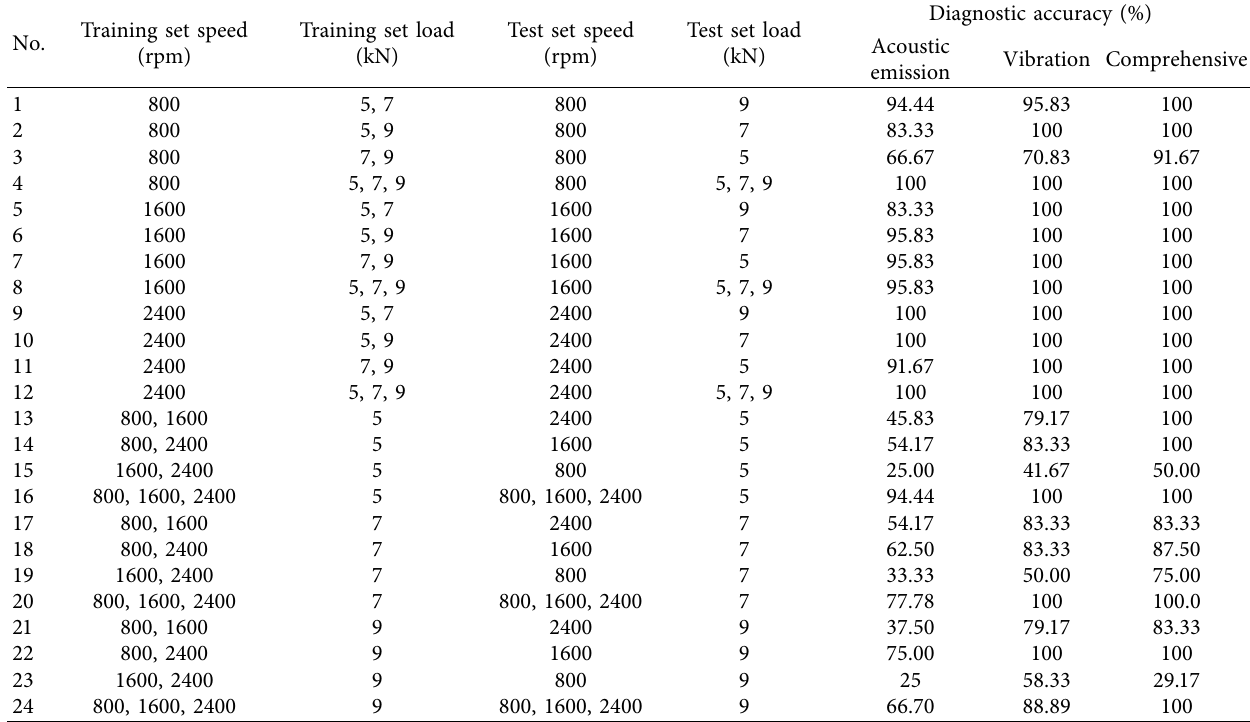
Table 3: Accuracy rate of single condition fault